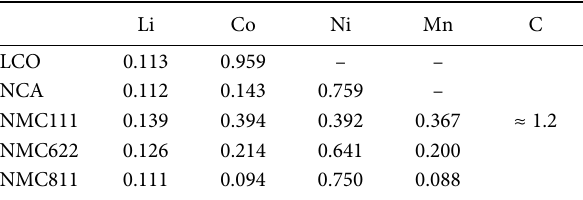
Table 2. Li, Co, Ni, Mn, Al requirements for common battery cath- odes (kg/kWh). 18